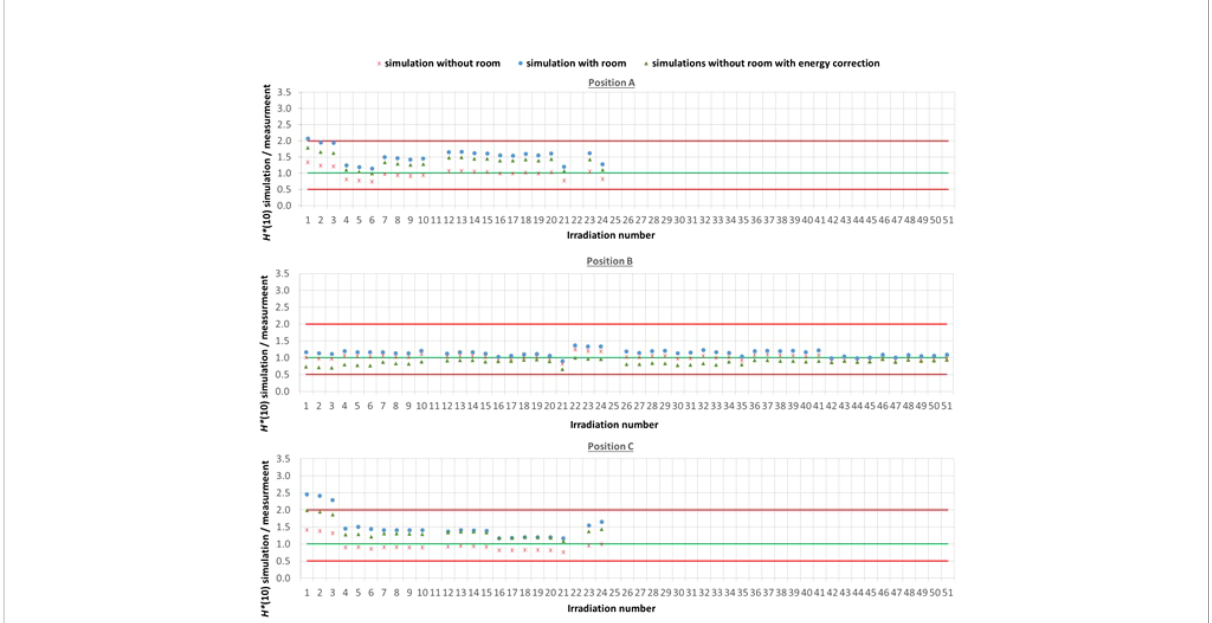
FIGURE 5 Plots with the ratio of simulated over measured H*(10) for positions (A – C) for the Skandion measurement campaign. Three cases are shown: simulations without room (red crosses), simulations with room (blue circles) and simulations without room and correction for the imperfect